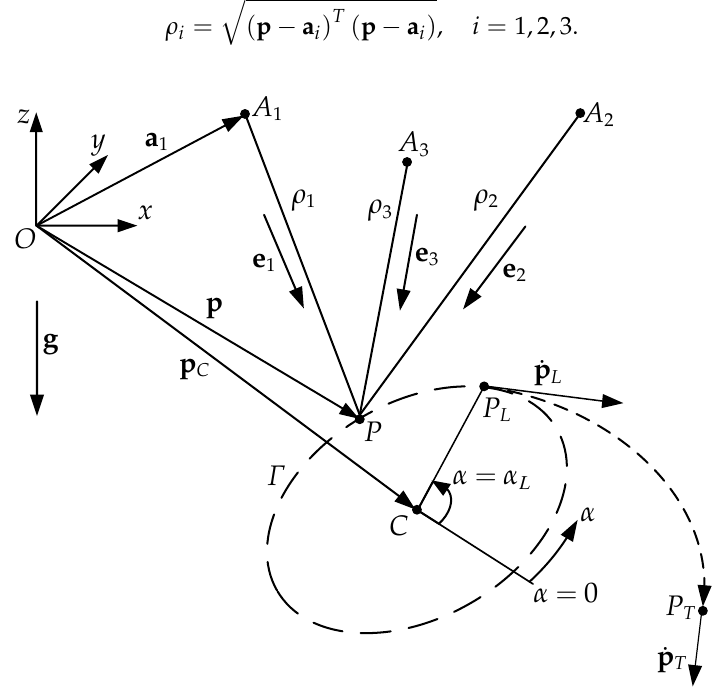
Figure 1. A 3-DoF (Degrees-of-Freedom) spatial Cable-Suspended Parallel Robot (CSPR) launching an object from the launch point P L to the target point P T .